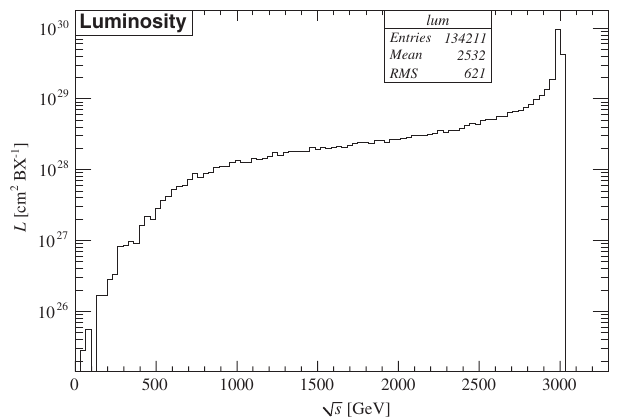
FIG. 13. CLIC nominal luminosity spectrum at ideal condi- tions; the spectrum includes contributions from coherent pairs and initial state